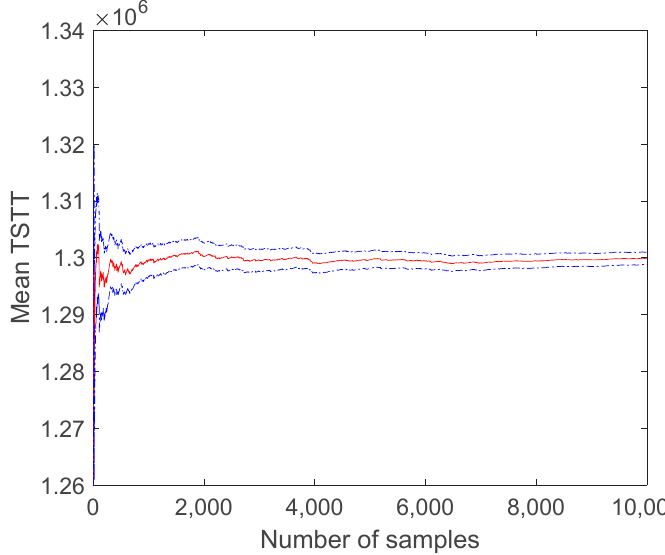
Figure 9. Convergence of mean total system travel time (TSTT) according to the number of samples.